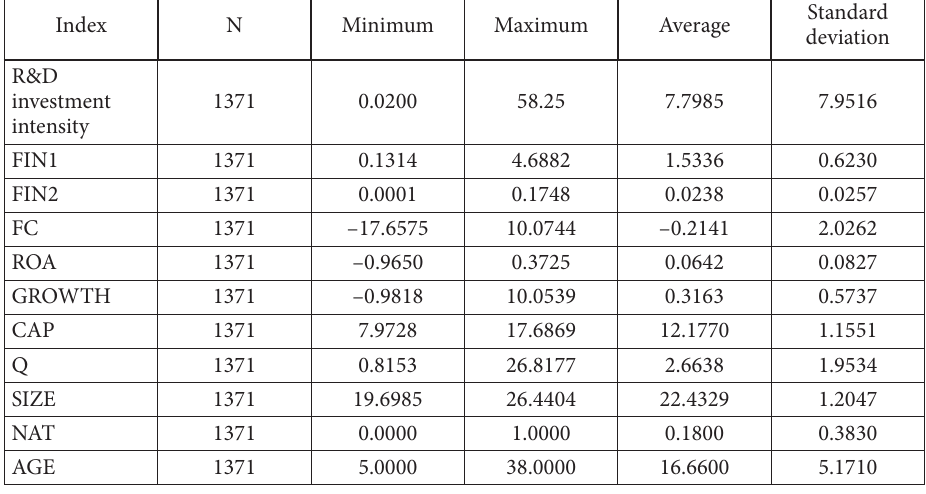
Table 4. Results of descriptive statistics